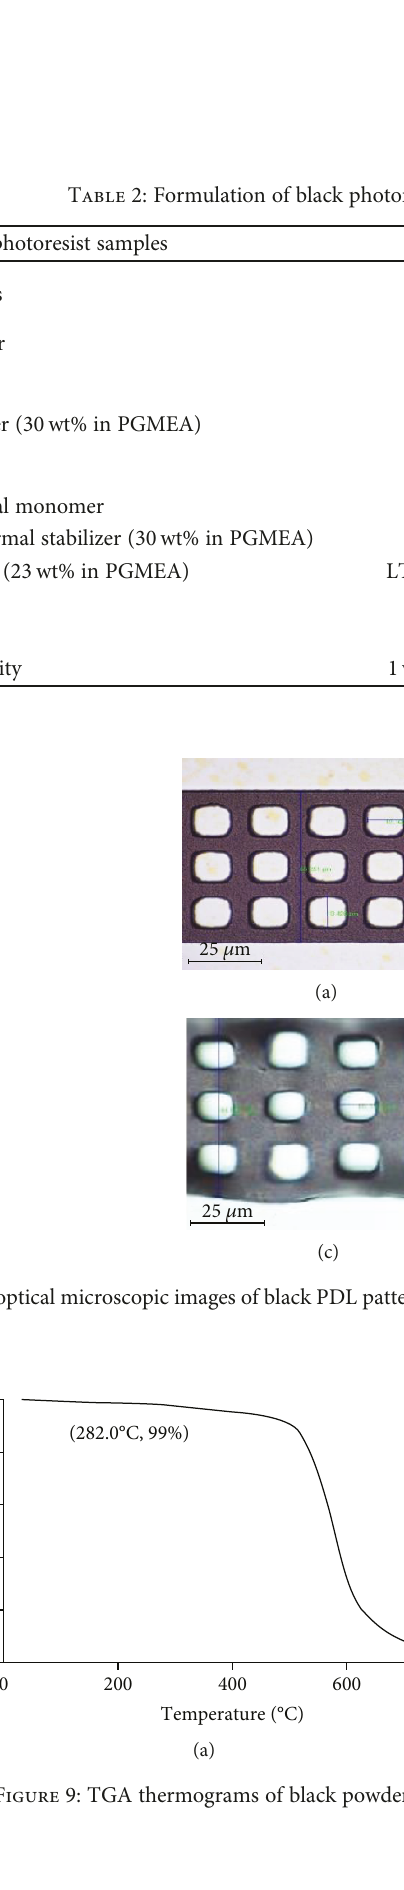
Figure 9: TGA thermograms of black powders obtained from the black PDL patterns. (a) PT-0 and (b)